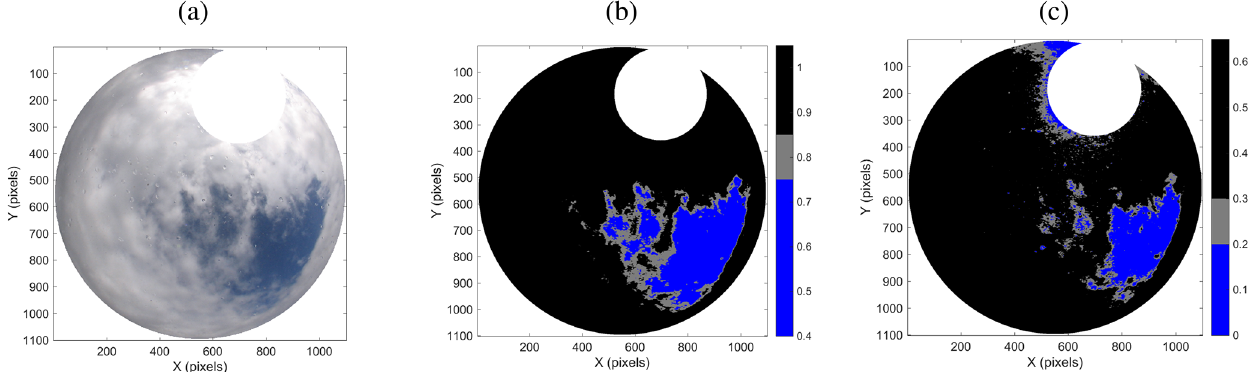
Figure 8. (a) Cropped image of 7 March 2018 at 11:00UTC. (b, c) Result for cloudy, cloud-free, and uncertain pixels from the (b) absolute process and (c) differential